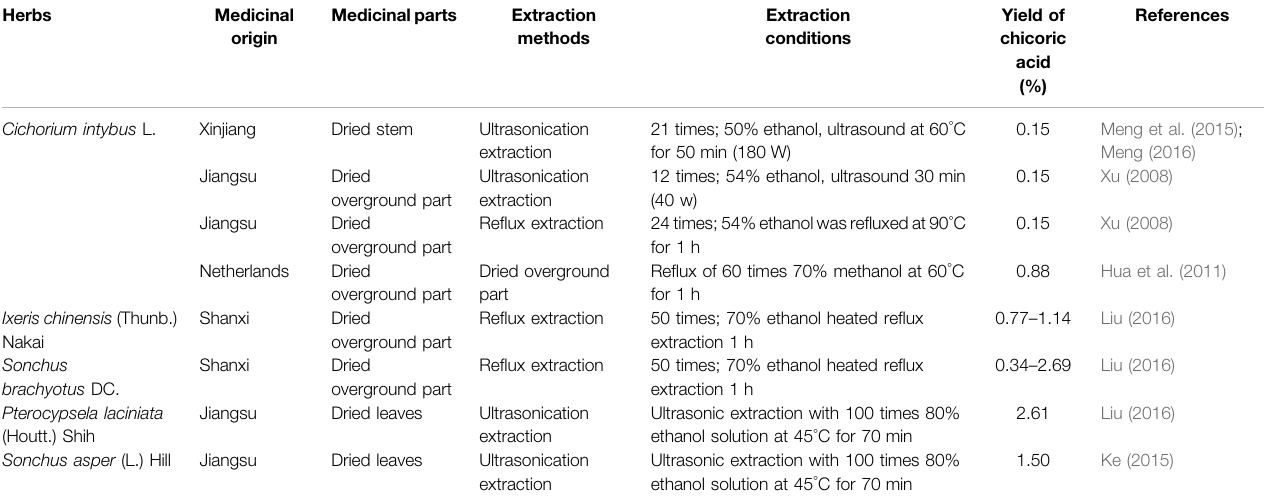
TABLE 3 | Comparison of the content of chicoric acid in different plants.